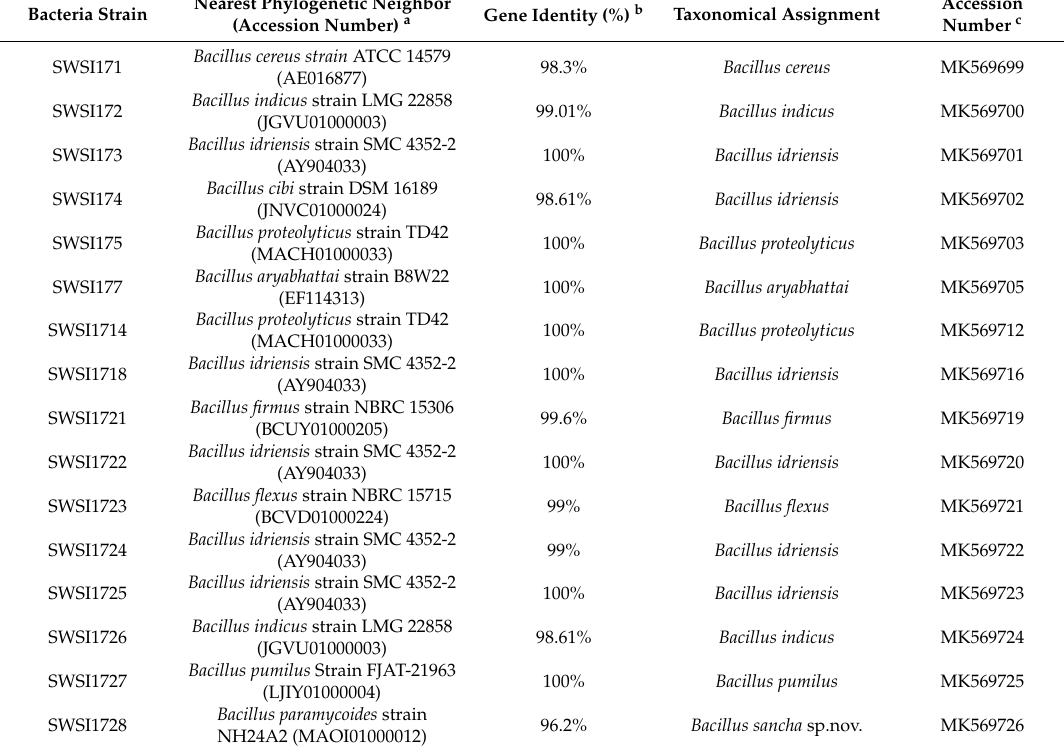
The online BLAST results of 16S rRNA gene sequences for the 43 inorganic phosphate-solubilizing bacteria (IPB) strains in the sediments of Sancha